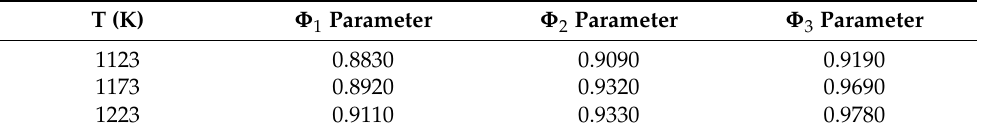
Table 2. Calculated values of dimensionless parameters Φ i with i = (1 to 3) based on Equation (24). T (K) Φ 1